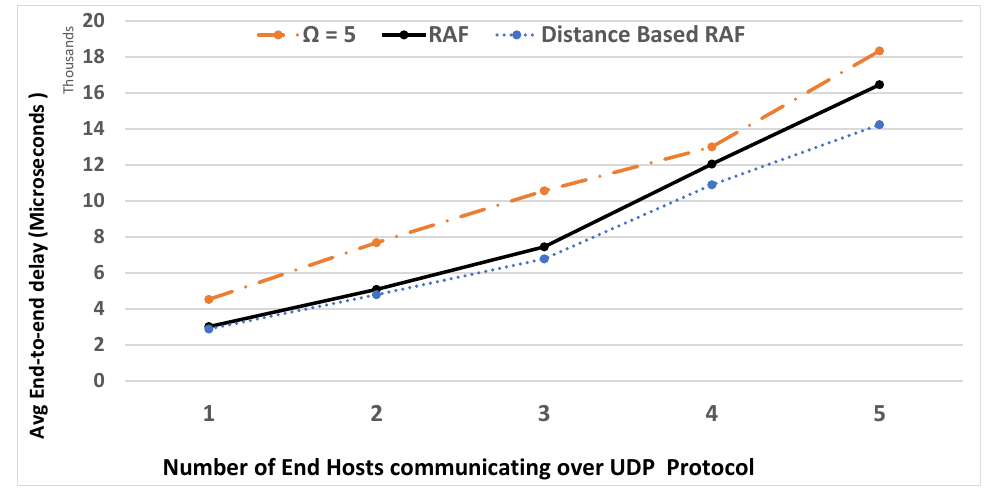
Figure 4. Comparative average end-to-end delay of existing and reliable path communication. RAF minimizes the installation of the memory frequent flow rule entries. When an Open switch receives frequent flow entries for installation, its memory becomes a bottleneck. Figure 5 shows a relatively smaller number of flow-forwarding rules for the installation of a switch TCAM using RAF compared to the existing approaches. However, we have observed that the RAF and DRAF present a close number of flow rule entries in this perspective. The length of the path (i.e., a variable number of intermediate forwarding devices in a path) is a factor that affects the possible number of control